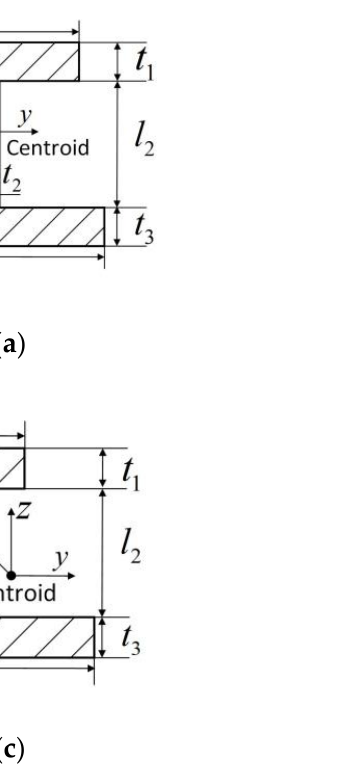
Figure 9. Cross-sections of physical replacements: ( a ) I, ( b ) box, and ( c ) open. Table 5. Properties of I, box, open cross-sections.